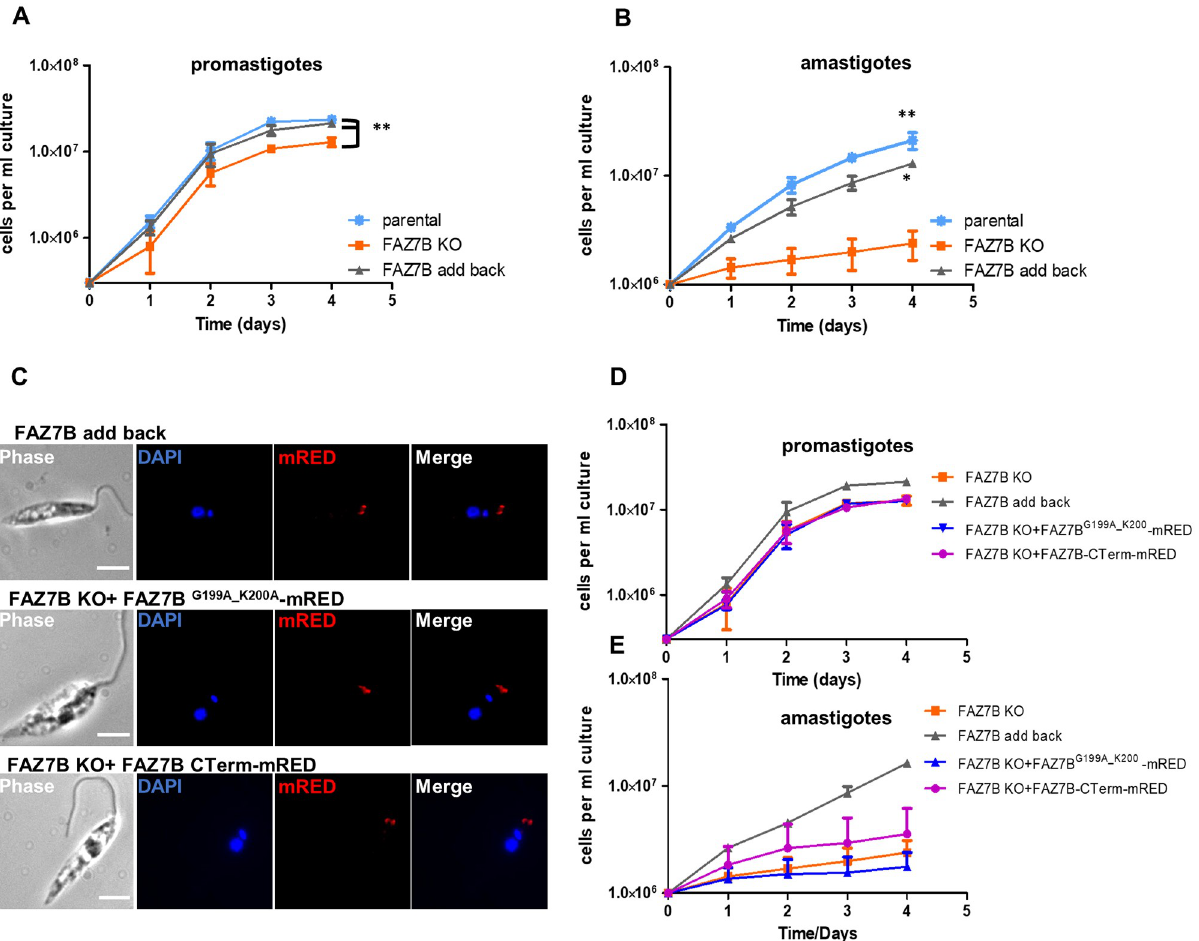
Fig 2. FAZ7B is required for normal cell growth in promastigote and amastigote stages. (A-B) Representative growth curves (log scale) of promastigotes (A) and axenic amastigotes (B) of the parental, FAZ7B KO and FAZ7B add-back cell lines over a 4-day course. Cell density was determined by counting at 24 h intervals and the mean ± SD of three independent experiments was plotted. � p < 0.05, �� p < 0.01 (Student’s t -test). (C) Fluorescence micrographs of whole cells from FAZ7B add-back (upper panel) and mutant-complemented cell lines: FAZ7B KO + FAZ7B G199A_K200A - mRED (middle panel) and FAZ7B KO + FAZ7B C-term-mRED (lower panel) cell lines. Scale bar: 5 μ m. Growth curves of promastigotes (D) and axenic amastigotes (E) of the FAZ7B KO, FAZ7B add-back, FAZ7B KO+ FAZ7B G199A_K200A -mRED and FAZ7B KO+ FAZ7B C-term-mRED cell lines over a 4-day course. Cell density was determined by counting at 24 h intervals and mean ± SD of triplicate values was plotted.